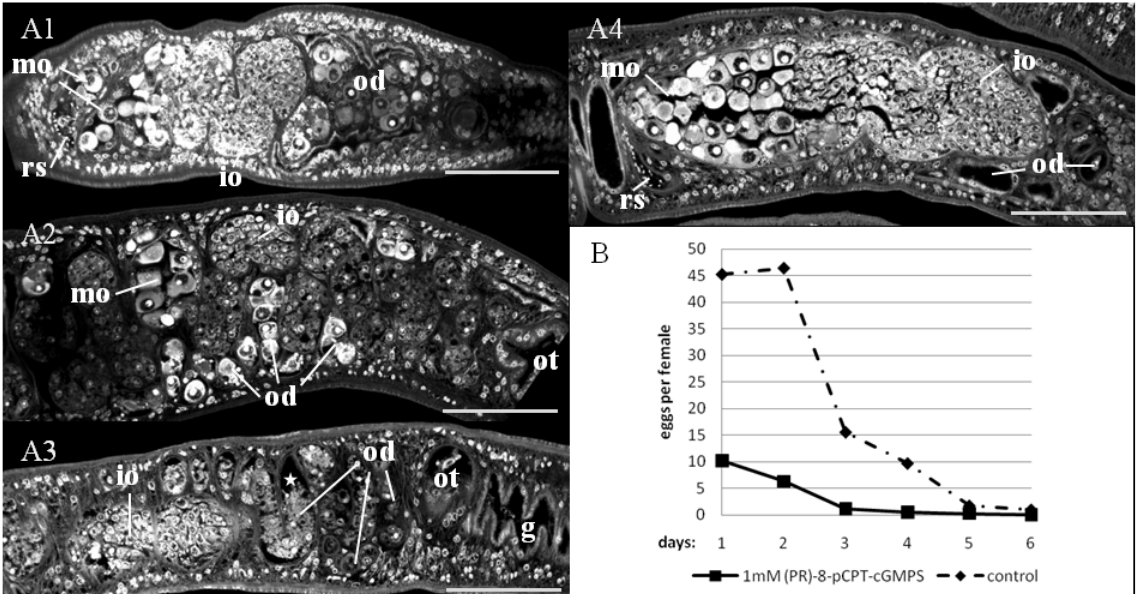
Fig. 4 – Effects of inhibitor treatment on female morphology (analyzed by confocal laser scanning microscopy) and egg production (analyzed in vitro ). A , influence of inhibitor treatment on the ovary and oviduct of a female worm treated with inhibitor for A1: two days, A2: four days, A3: six days; A4: untreated control after two days, which is representative for days 4-6 (scale bar: 75 μ m; g: gut; io: immature oocytes; mo: mature oocytes; od: oviduct; ot: ootype; rs: receptaculum seminis). B , comparison of egg production of inhibitor-treated (1 mM) versus control females, showing eggs per day and female. Supplementary data: videos showing treated (A) and control (B) worms in vitro at day 4 of the experiment.